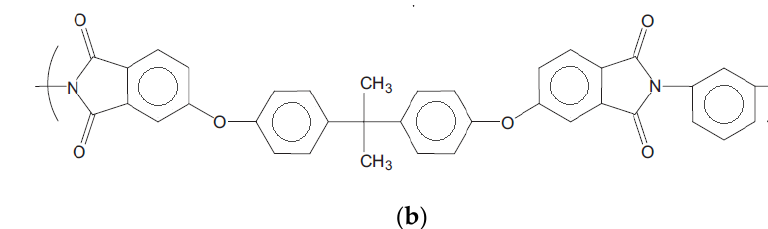
Figure 11. The PI ( a ) and PEI ( b ) molecular structures.